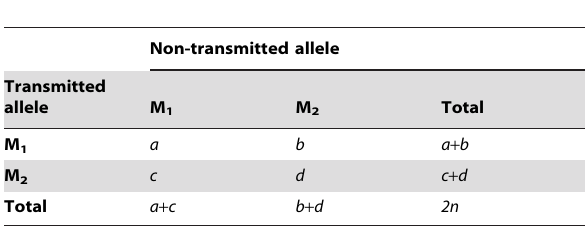
Table 1. Summary of the original TDT design in a 2 6 2